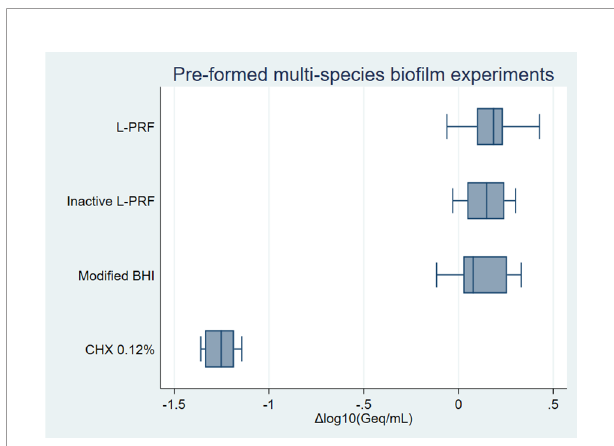
FIGURE 3 | Pre-formed multi-species bio fi lm experiments on P. gingivalis boxplot. Negative values represent bacterial growth inhibition while positive values indicate bacterial growth. D log 10 (Geq/mL), Differences in logarithmic values of genome equivalents per millilitre; L-PRF, Leucocyte- and platelet rich fi brin; PBS, Phosphate-buffered saline; CHX, Chlorhexidine; HRP, Horseradish peroxidase.